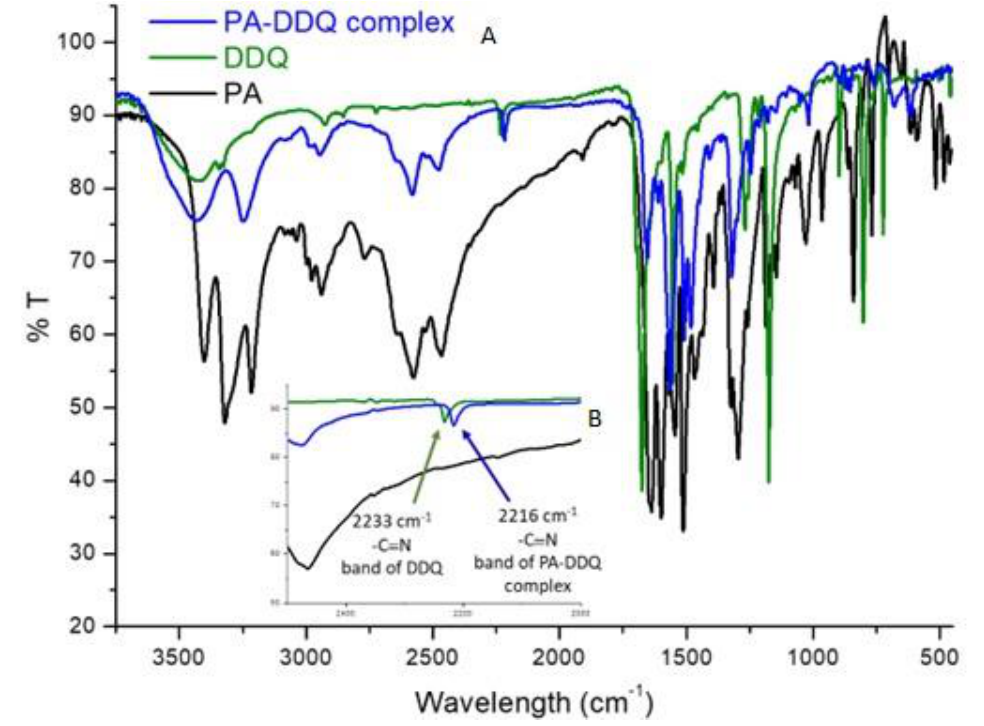
Figure 6. Comparison of IR spectra of PA, DDQ, and PA-DDQ complex: ( A ) whole spectra; ( B ) showing the characteristic -C N band of DDQ and PA-DDQ complex. Table 3. IR spectral bands of PA, DDQ, and their complex (PA-DDQ).